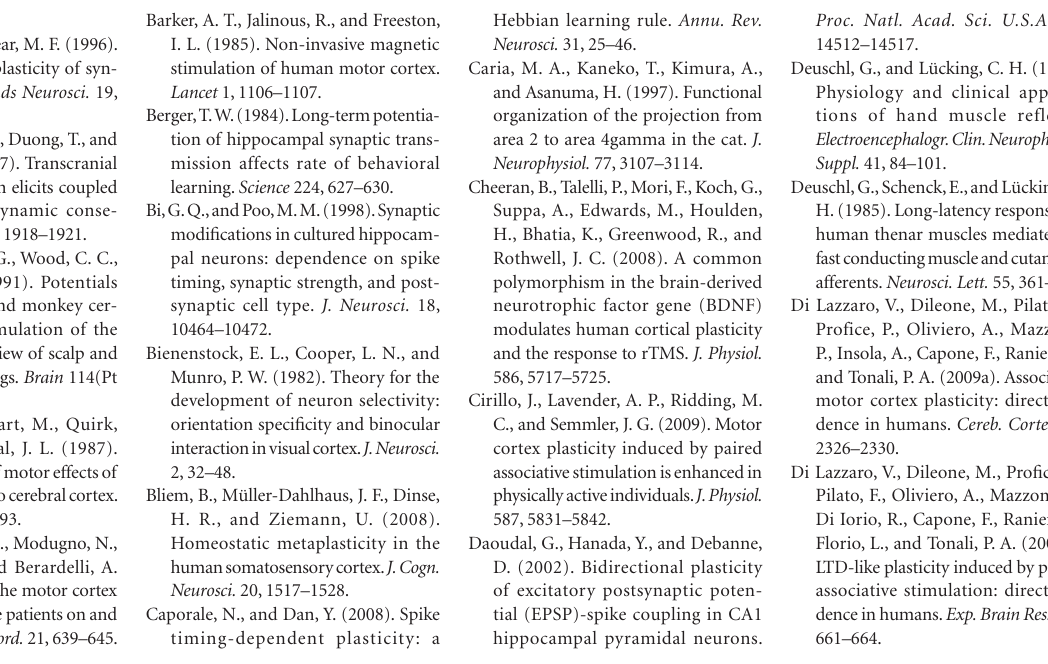
Figure 6 | Bidirectional modulation of motor learning in healthy subjects by prior PAS-induced timing dependent LTP- and LTD-like plasticity. Motor learning was indexed by an increase in peak acceleration (ACC) of the trained thumb flexion movement during two blocks of 15 min motor practice (MP) normalized to baseline peak ACC before MP. (A) MP immediately following PAS (black circles) or PAS (white circles) resulted in an enhancement of N20 + 2 N20 − 5